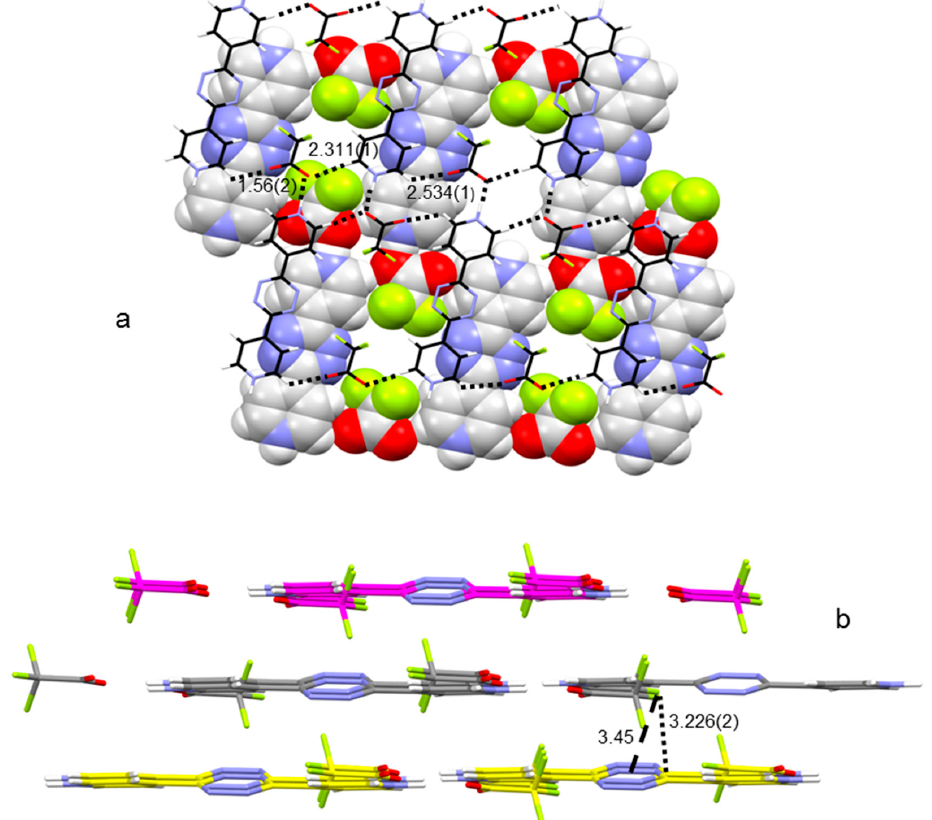
Figure 3. Crystal packing of H 2 L(CF 3 CO 2 ) 2 . ( a ) Polymeric diamond-shaped planar grid which develops in the (1 − 21) crystallographic plane; ( b ) adjacent layers (F ∙∙∙ ring centroid and shortest F ∙∙∙ C distances are displayed). All distances are in Å. Color code: ( a ) C, grey; H, white; N, blue; O, red; F, greenish yellow; ( b ) as above, but C is also magenta and yellow, depending on the plane.